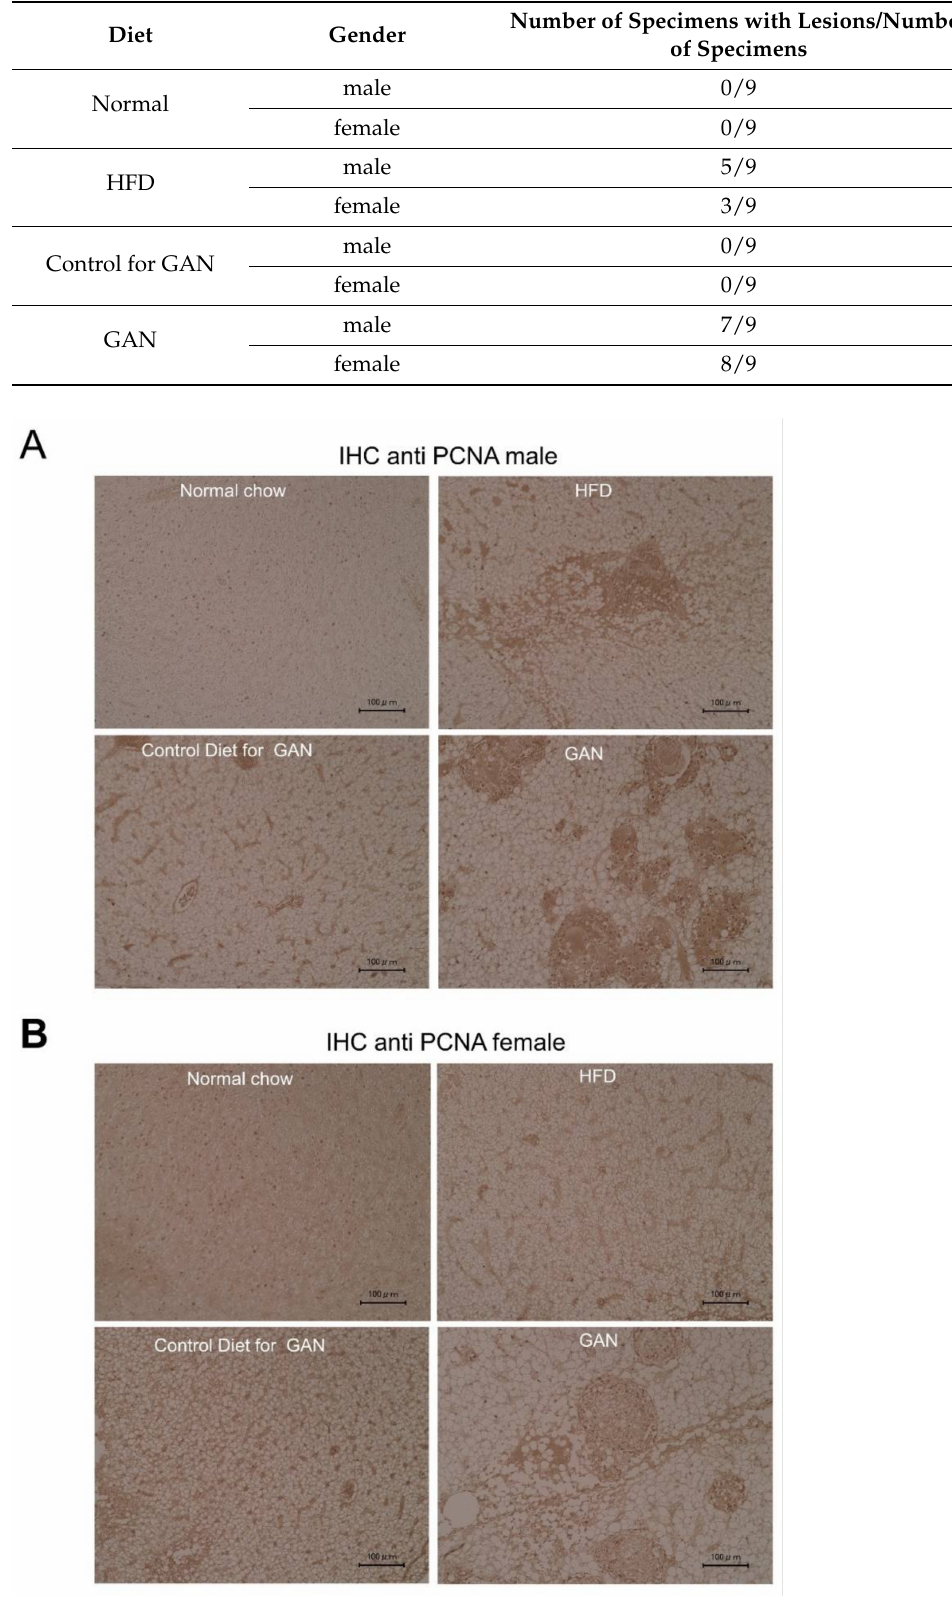
Figure 5. Evaluation of PCNA expression in the liver by immunohistochemistry. ( A ) male, ( B ) female. Anti-PCNA antibodies. The black scale bar represents 100 µ